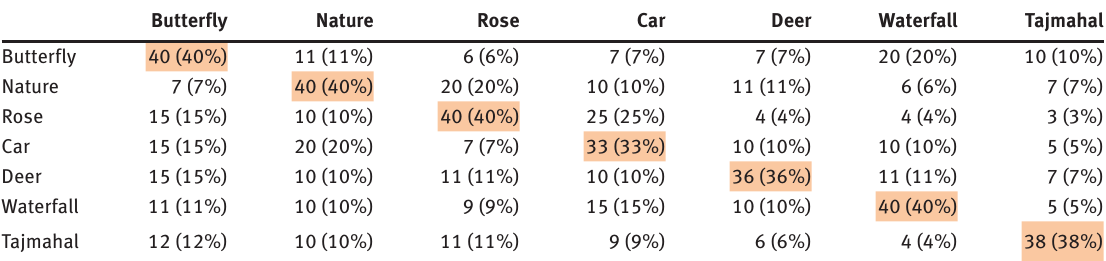
Table 3: Confusion Matrix for Theorem